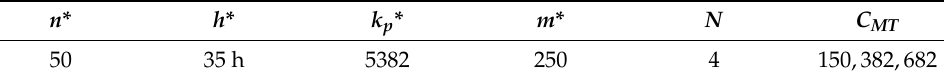
Table 16. Optimal control chart parameters.